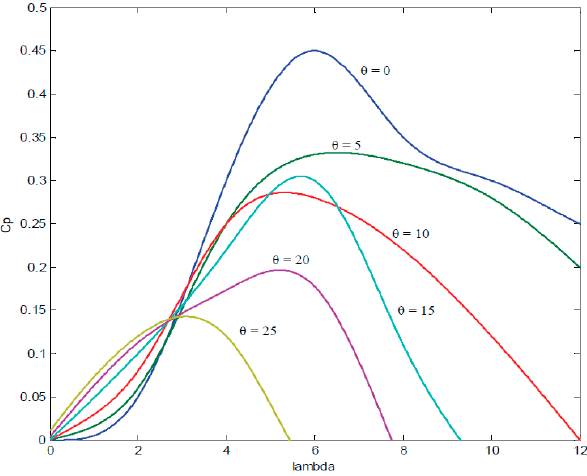
Figure 2. Performance coefficient behavior in accordance with the pitch angle and the tip speed ratio.